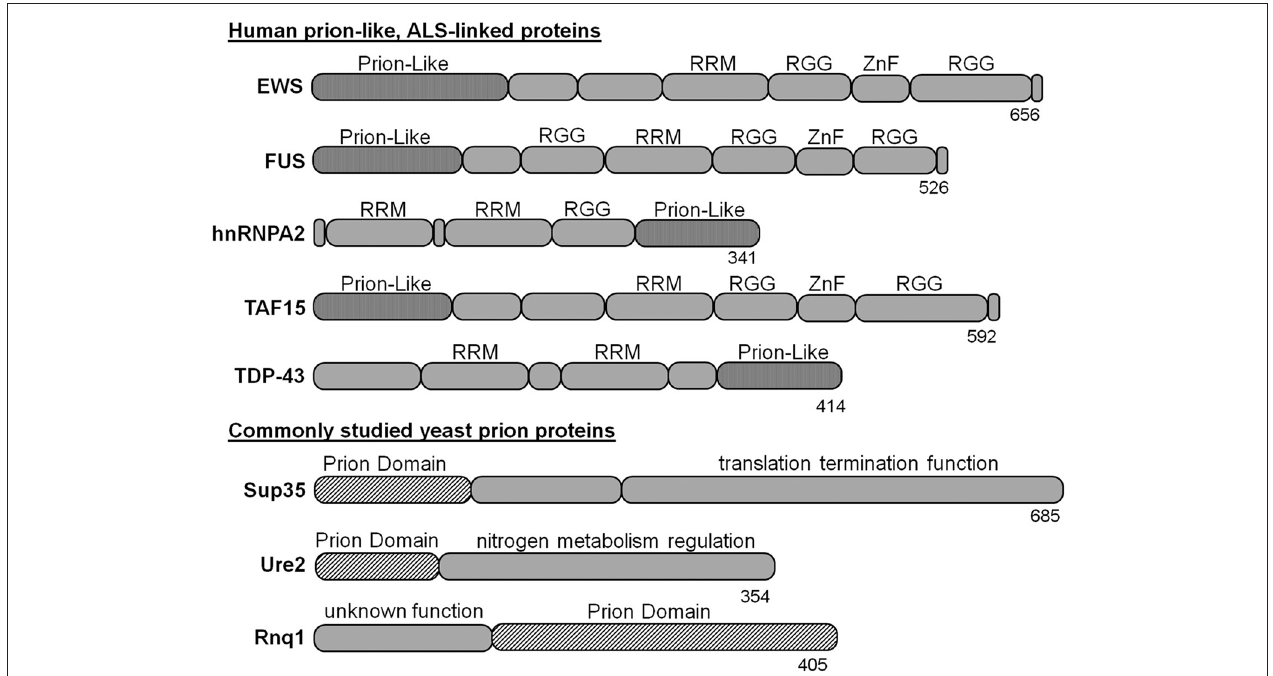
FIGURE 1 | Amyotrophic lateral sclerosis (ALS)-linked proteins with yeast prion-like domains have been modeled in yeast. The prion domains of naturally occurring yeast prion proteins have similar size and composition, but are not homologous to the prion-like domains of ALS-linked proteins. The tools for studying yeast prions have been applied to ectopic expression of human disease proteins to evaluate aggregation and toxicity mechanisms. RRM, RNA recognition motif; RGG, arginine-glycine-glycine rich domain; ZnF, zinc finger